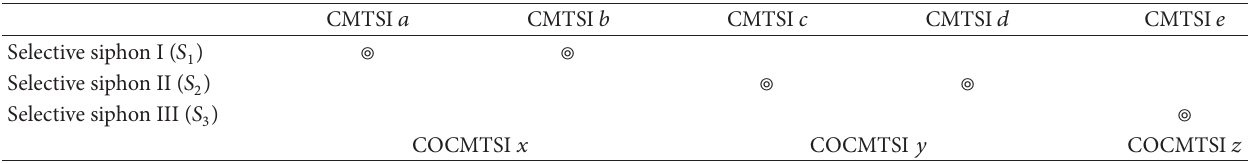
Table 1: The relations between selective siphons and CMTSIs.